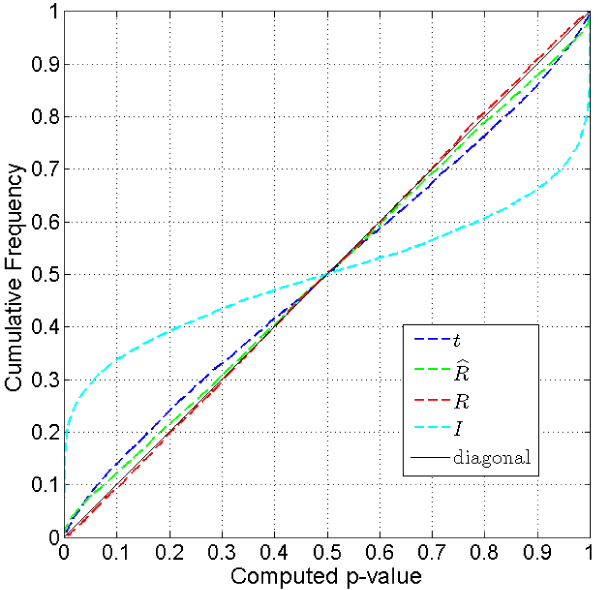
Cumulative distribution of p-values for one-sided test case with sample size n = 5. The corrected p-values based on a t-distribution (blue line) and the  (green line) are near diagonal, while the naïve p-value (cyan line) overstates the significance of the test. We can correct the problem when we know the true correlation, R between the genes in a GO term (red line).